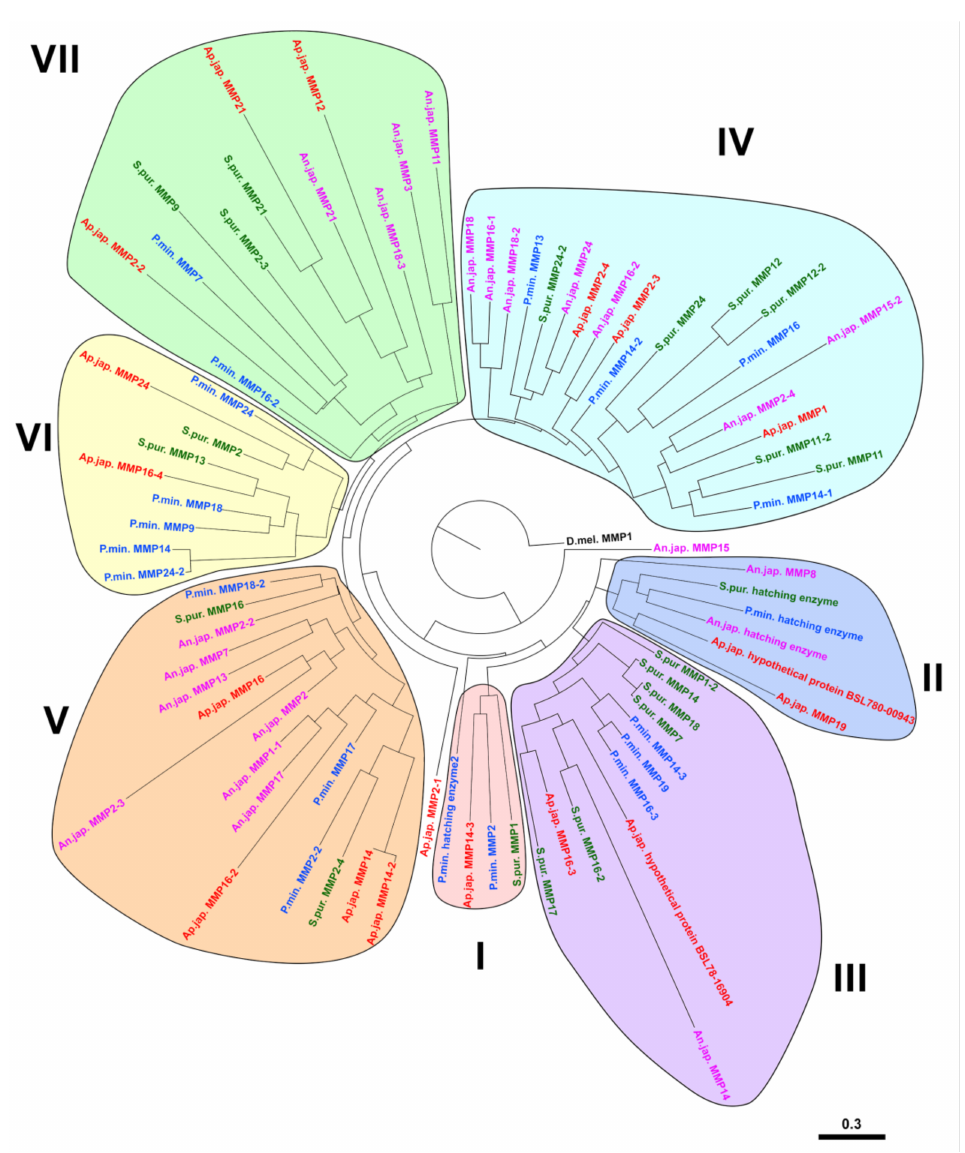
Figure 6. Phylogenetic tree showing the relationships of MMPs of echinoderms. Crinoids ( Anneissia japonica )—pink color, asteroids ( Patiria miniata )—blue color, echinoids ( Strongylocentrotus purpuratus )— green color, holothurians ( Apostichopus japonicus )—red color. Determination of conserved regions of the putative amino acid sequences was carried out using the Gblock program. Construction of the phylogenetic tree was done using the MrBayes/Maximum Likelihood algorithm and the online service CIPRES (http://www.phylo.org, accessed on 15 March 2021). The nucleotide and amino acid sequences were analyzed using the Partitionfinder 2.1.1 [101,102]. The trees were visualized in